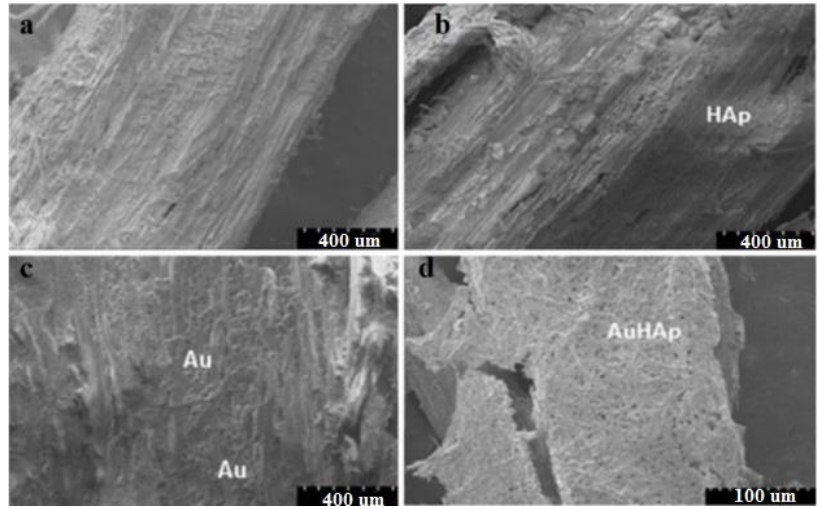
Figure 3. SEM images of the treated wood: ( a ) old wood, ( b ) old wood treated with HAp, ( c ) old wood treated with Au, ( d ) old wood treated with Au and Hap. Reused from an open access source